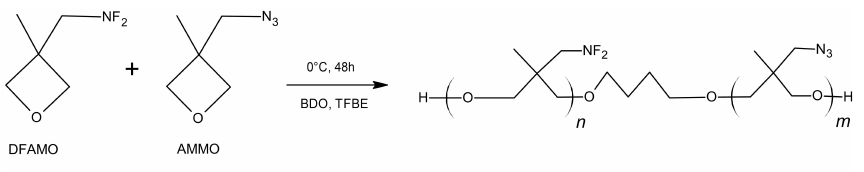
Figure 8. Schematic representation of the synthesis of